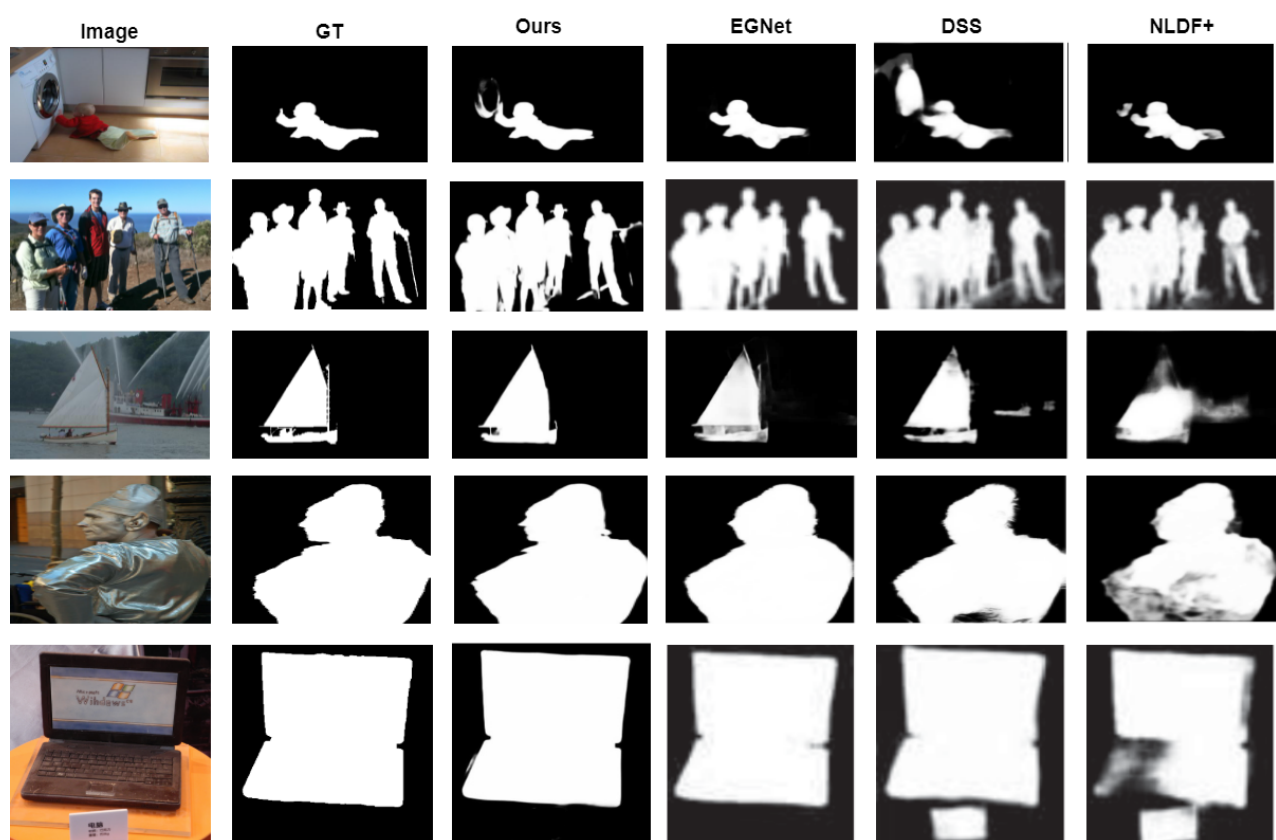
Figure 4. Visual comparison of segmentation results obtained by the proposed Revise-Net model with several state-of-the- art baselines.